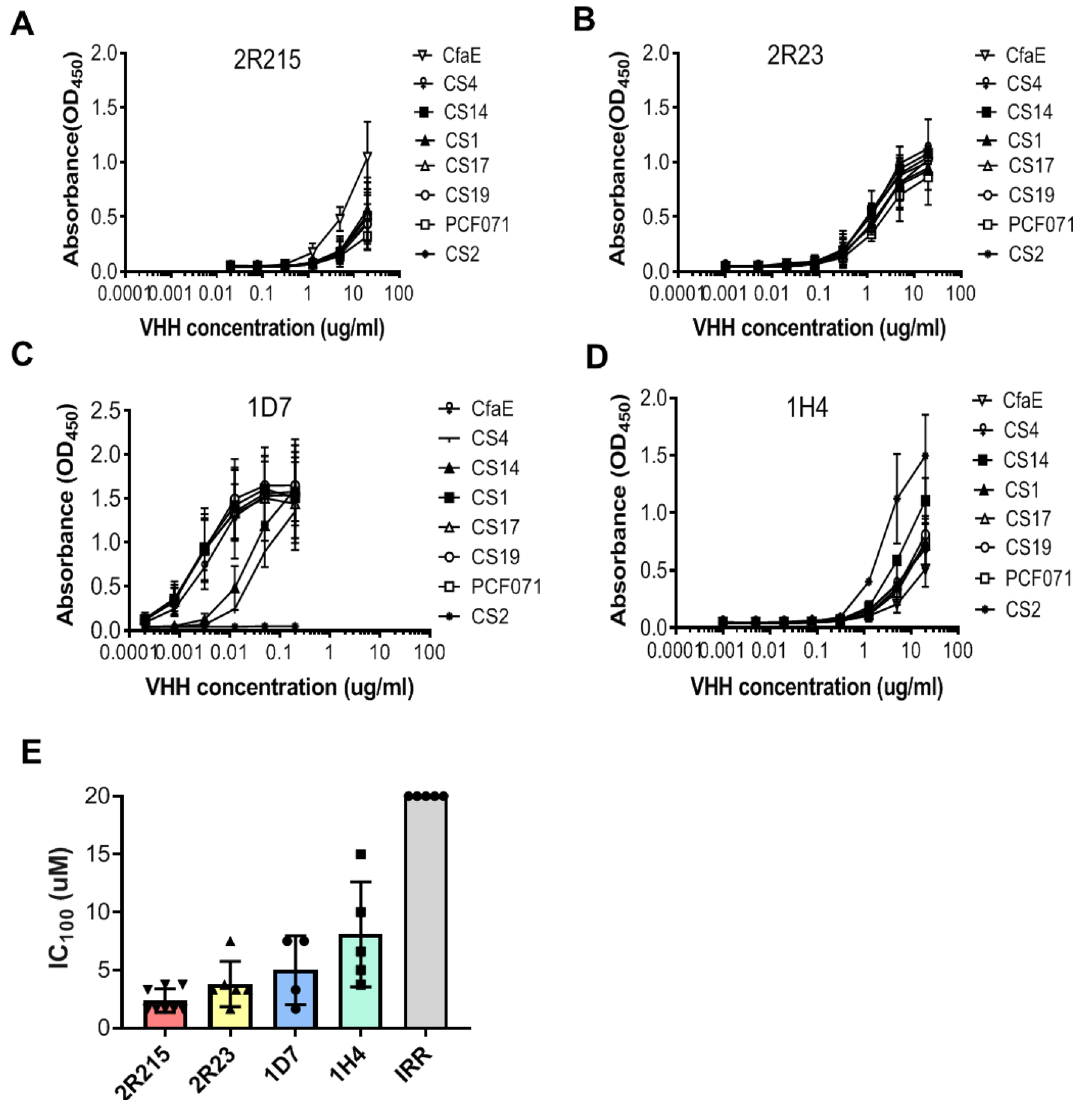
Figure 2. Selected anti-CfaE nanobodies show cross-reactivity against class 5 colonization factors. ( A – D ) Two yeast-derived clones (2R215 and 2R23) and two llama-derived clones (1D7 and 1H4) were examined by ELISA for binding to eight class 5 adhesins. These clones showed broad reactivity against multiple adhesins. Three biological replicates were performed. (E) The four lead nanobodies were tested for inhibition of mannose resistant hemagglutination (MRHA) against an ETEC strain expressing CFA/I (H10407). All nanobodies showed maximal inhibitory concentration (IC 100 ) in the micromolar concentration range (2.4–8 µM). Four to eight biological replicates were